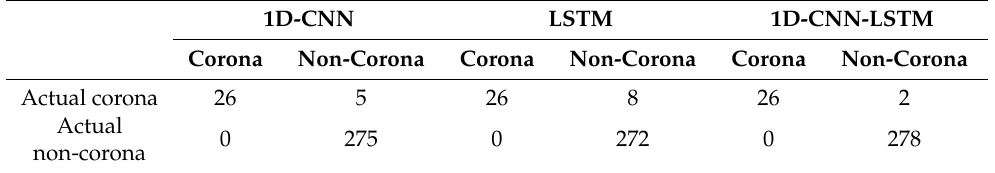
Table 7. Time domain corona fault classification output matrix for the training